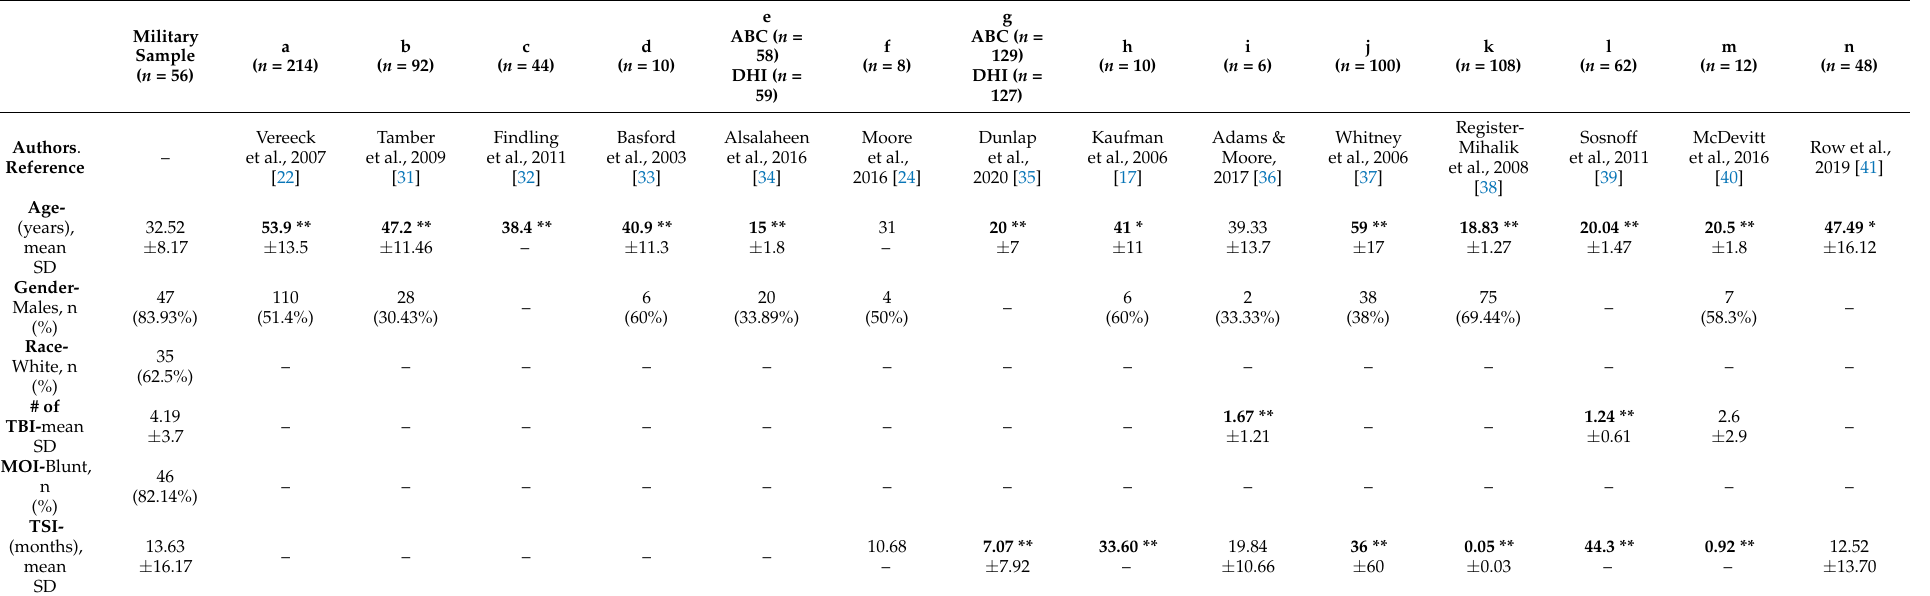
Table 1. Demographic characteristics of the study participants and comparable civilian studies.